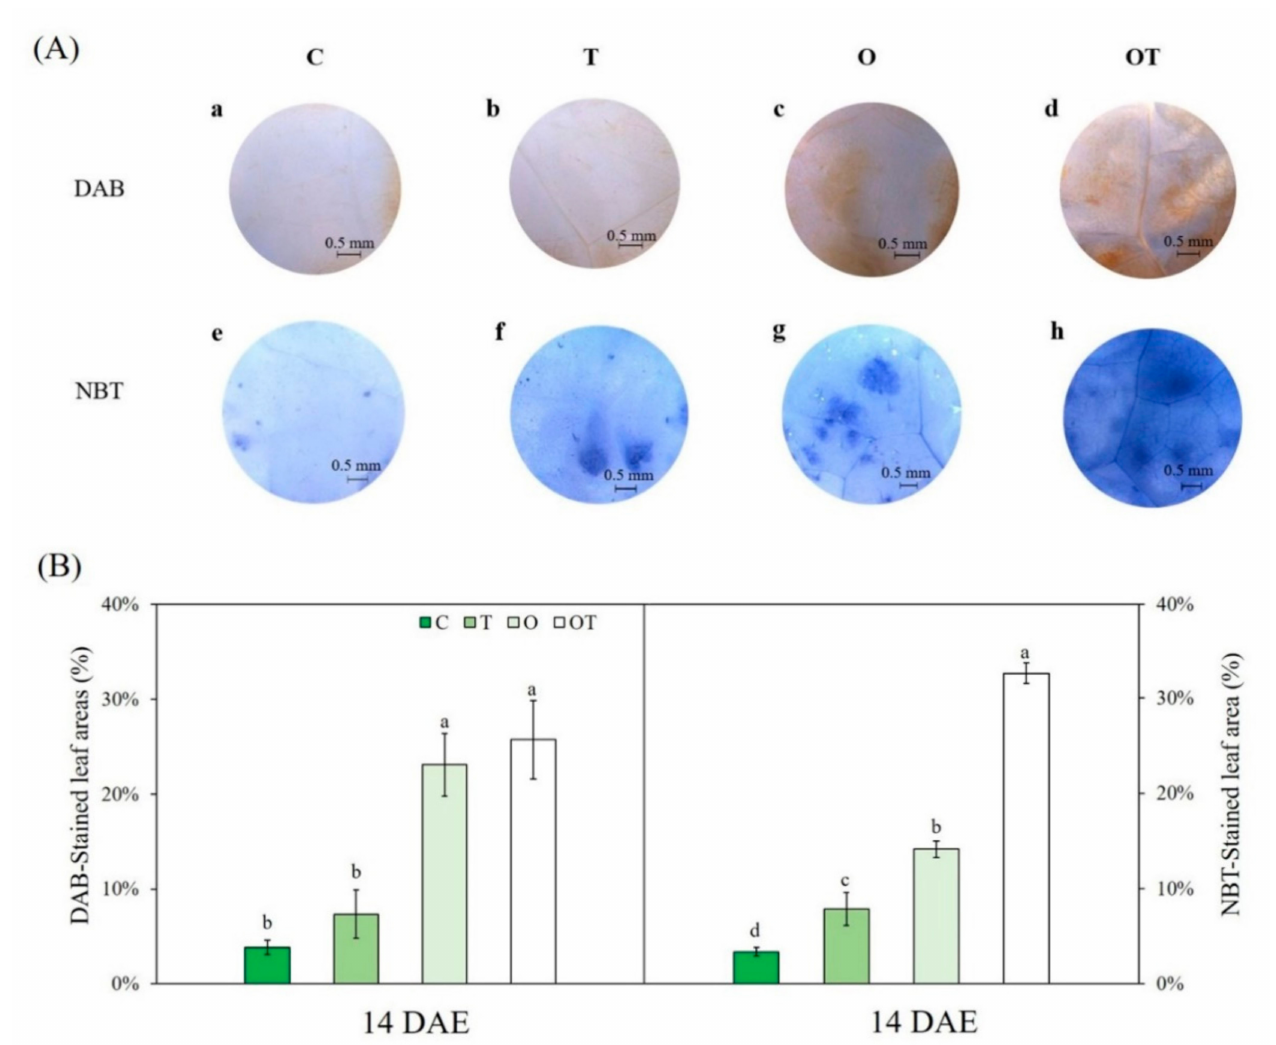
Figure 8. ( A ) Hydrogen peroxide (H 2 O 2 ) and superoxide (O 2 − ) accumulation and ( B ) percentage of 3,3 (cid:48) -diaminobenzidine (DAB)- and nitroblue tetrazolium (NBT)-stained leaf area of Brassica juncea L. under different ambient and supraoptimal temperatures and O 3 concentrations at 14 DAE. (a–d) Histochemical detection of H 2 O 2 in B. juncea leaves by DAB staining. (e–h) Histochemical detection of O 2- in B. juncea leaves by NBT staining. H 2 O 2 and O 2- accumulation under control conditions (a,e); at supraoptimal temperature and ambient O 3 (b,f); at optimal temperature and elevated O 3 (c,g); and at supraoptimal temperature and elevated O 3 (d,h) at 14 DAE. Scale bars = 0.5 mm. Data are plotted as mean ± SD ( n = 5). Different letters indicate significant differences among treatments at p < 0.05 according to Tukey’s honestly significant difference test. C: ambient O 3 + optimal temperature; T: ambient O 3 + supraoptimal temperature; O: elevated O 3 + optimal temperature; OT: elevated O 3 + supraoptimal temperature; DAE: days after the beginning of